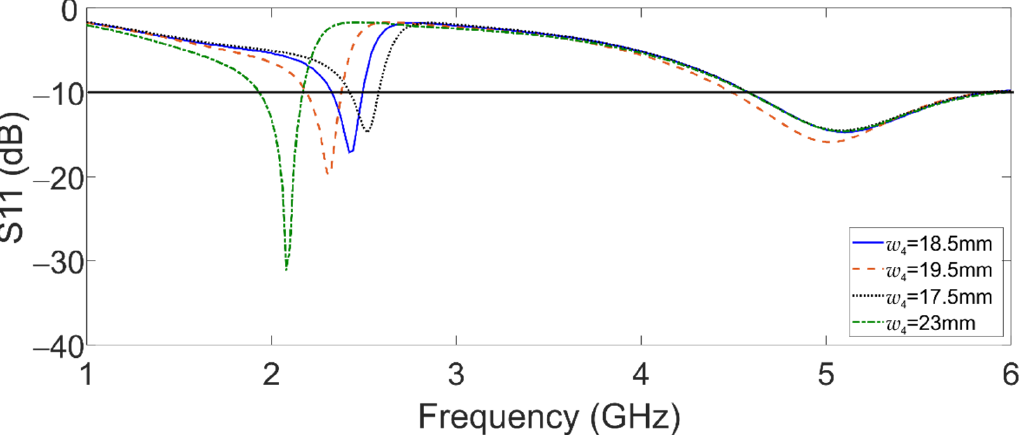
Figure 2. Simulated reflection coefficient of the dual ‐ band graphene antenna for w 4 variations.